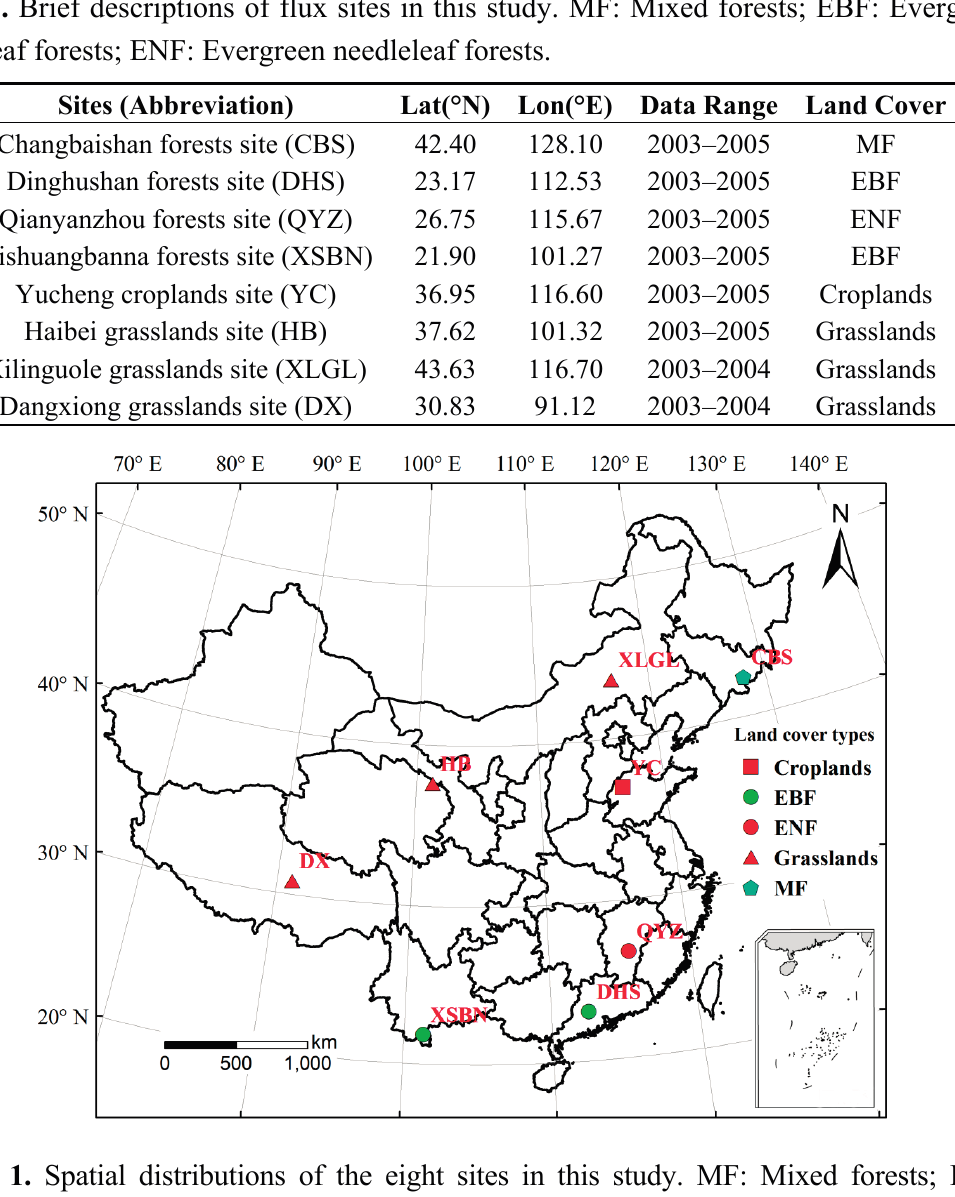
Figure 1. Spatial distributions of the eight sites in this study. MF: Mixed forests; EBF: Evergreen broadleaf forests; ENF: Evergreen needleleaf